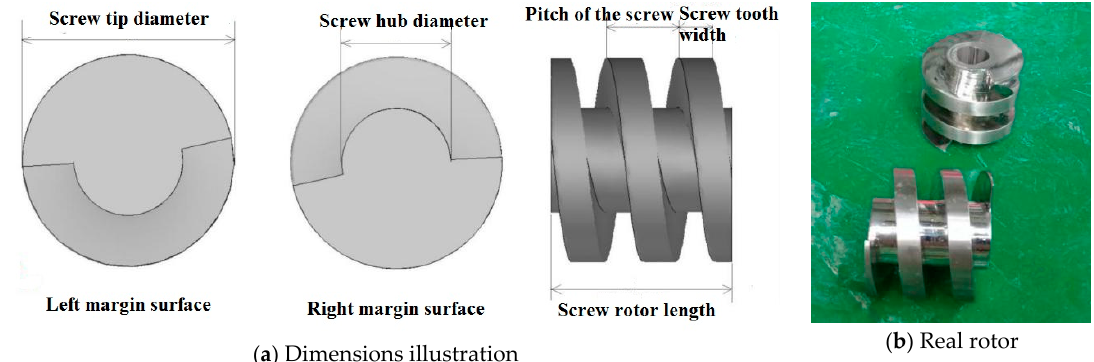
Figure 2. Screw pump rotor main parameters and the view of both screws (right side photography). See also Table 1.